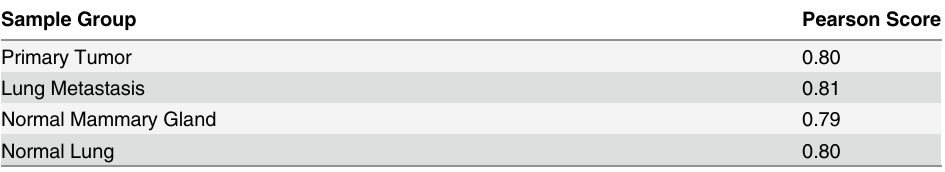
Table 3. Pearson Correlation Scores for Individual Sample Groups Between NanoString and Microar- ray (p-value < 0.001).